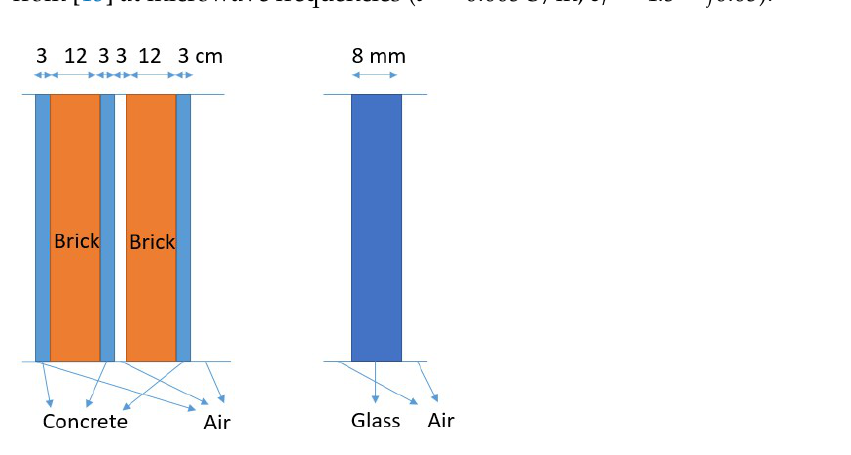
Figure 5. Structure of the interfaces considered for building reflections: concrete/brick walls (on the left) and single glass slab (on the right).